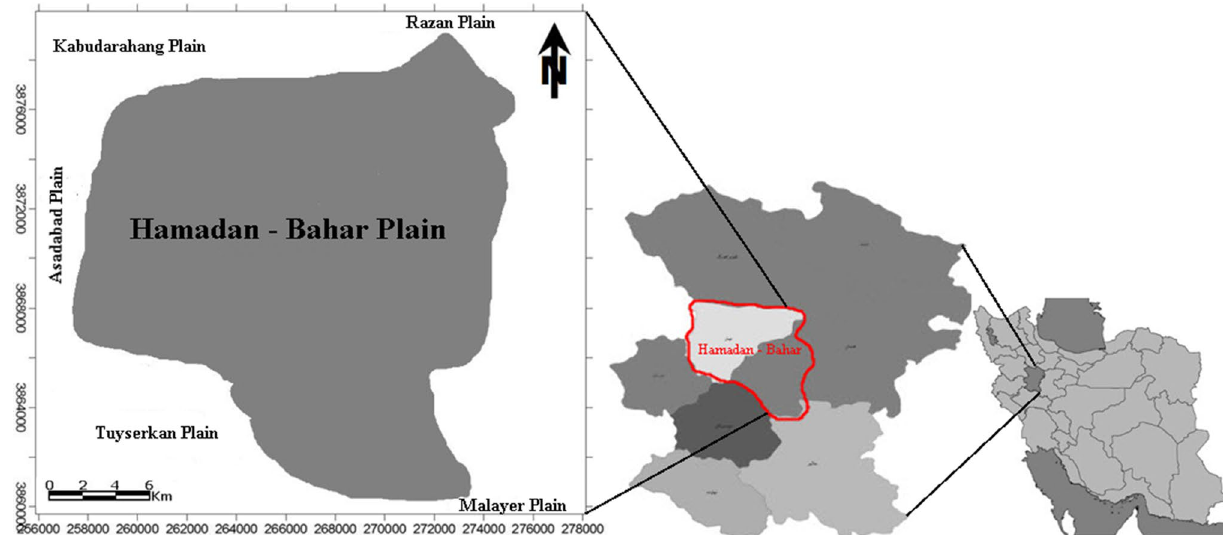
Fig. 1 The location of study in Hamadan–Bahar